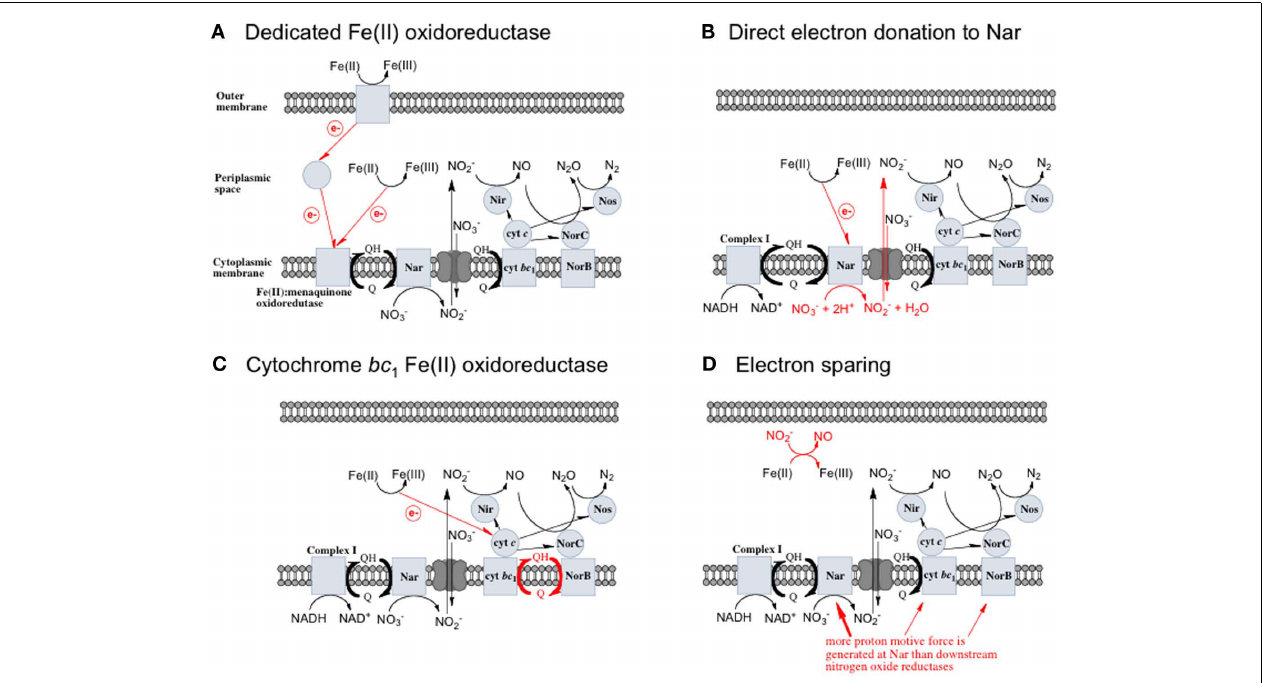
are pumped per electron at Nar than other nitrogen oxide reductases. If abiotic reactions dominate for the reduction of NO − , an energetic benefit is 2 conferred through an electron sparing mechanism. Nar, nitrate reductase; Nir, nitrite reductase; Nor, nitric oxide reductase; Nos, nitrous oxide reductase; QH 2 , reduced quinone; Q, oxidized quinone; bc 1 , cytochrome bc 1 ; cyt c , cytochrome